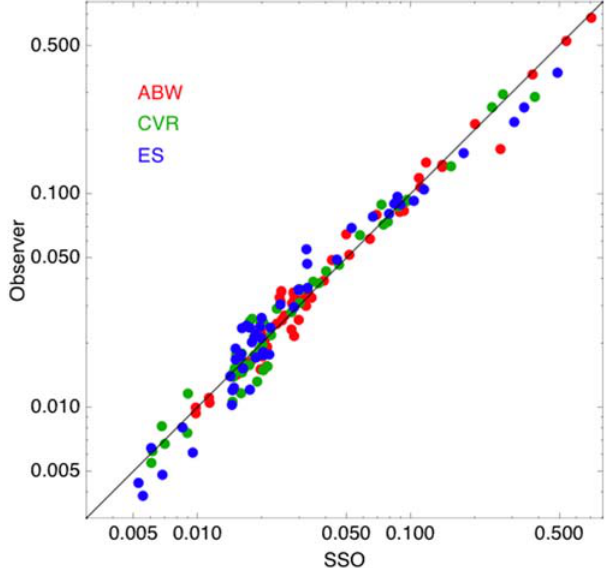
Figure 13. Human observer contrast thresholds versus SSO predictions for all aircraft targets.